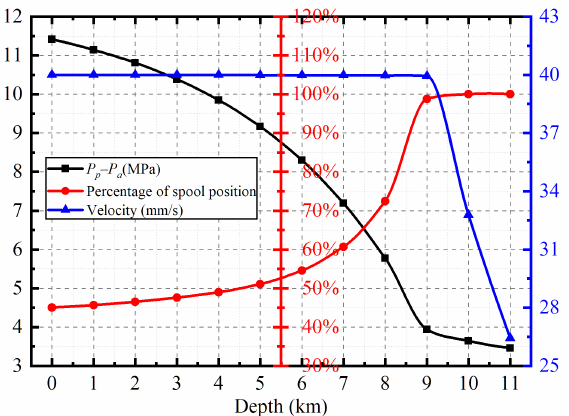
Figure 12. Pressure difference between port p and port a of the servo valve, percentage of spool position, and velocity of hydraulic cylinder at 8 s when